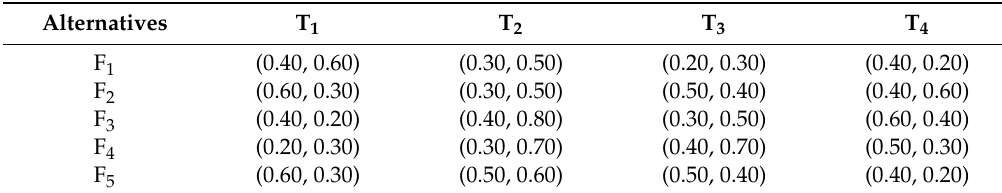
Table 4. Pythagorean fuzzy matrix by DM 4.